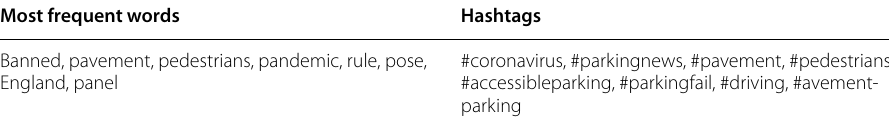
Table 7 Hashtags, and most frequent words within the pavement parking community Most frequent